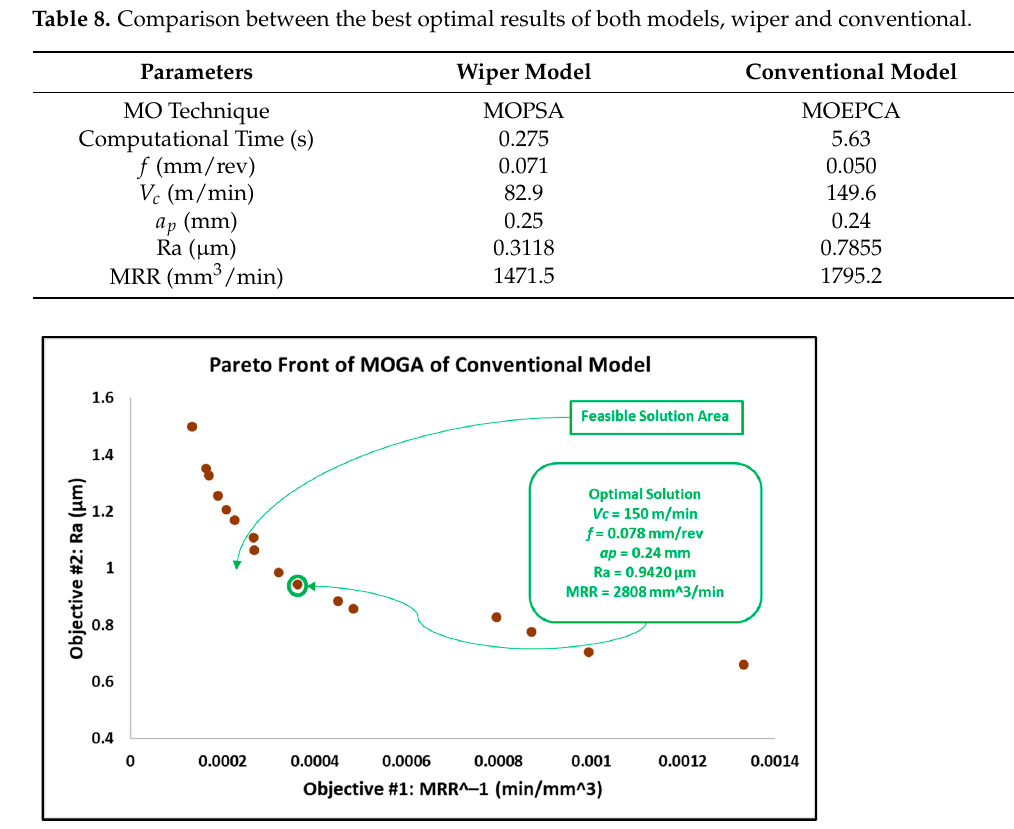
Figure 11. Pareto front plot of MOGA solution of the conventional model.